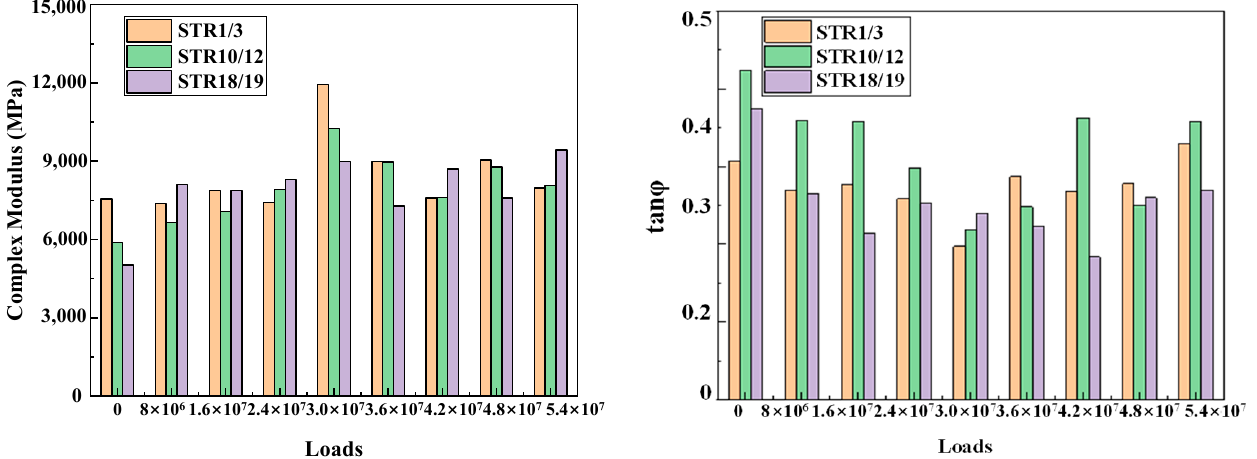
Figure 13. Complex modulus and phase angle at 20 °C for different loading cycles.